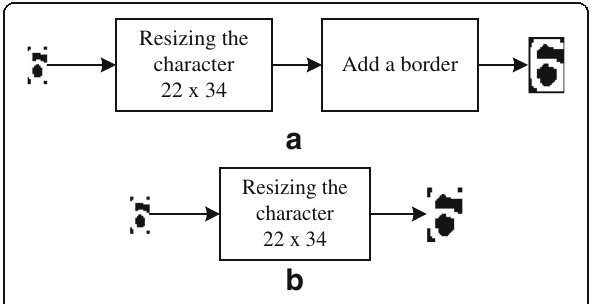
Fig. 4 The two preprocessing stages for the proposed OCR algorithms. a Feature extraction-based algorithms. b Template matching-based algorithm